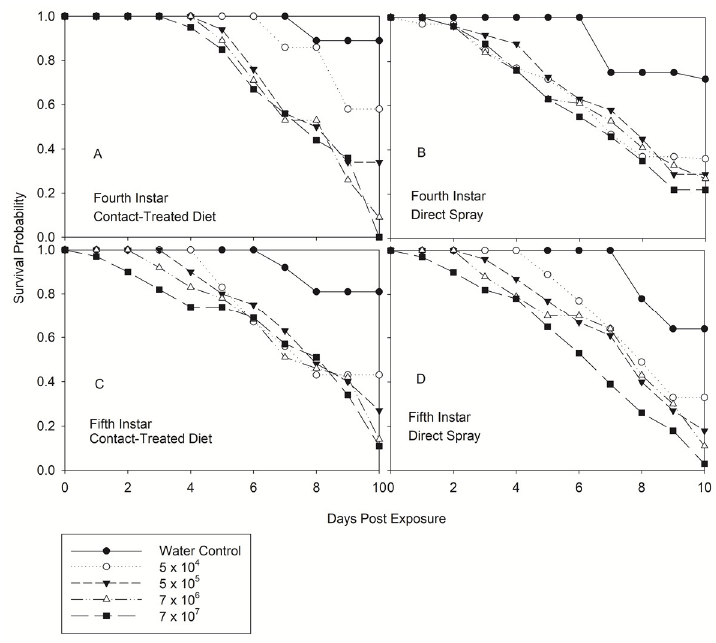
Figure 2. Product-limit survival estimates for 4th and 5th instars of Nezara viridula exposed by contact (treated diet) ( A , C ) and direct spray ( B , D ) to Beauveria bassiana , Delta native NI8 strain at different concentration. Insects were fed with an artificial diet ( p = 0.05, LIFETEST of Equality over Strata).